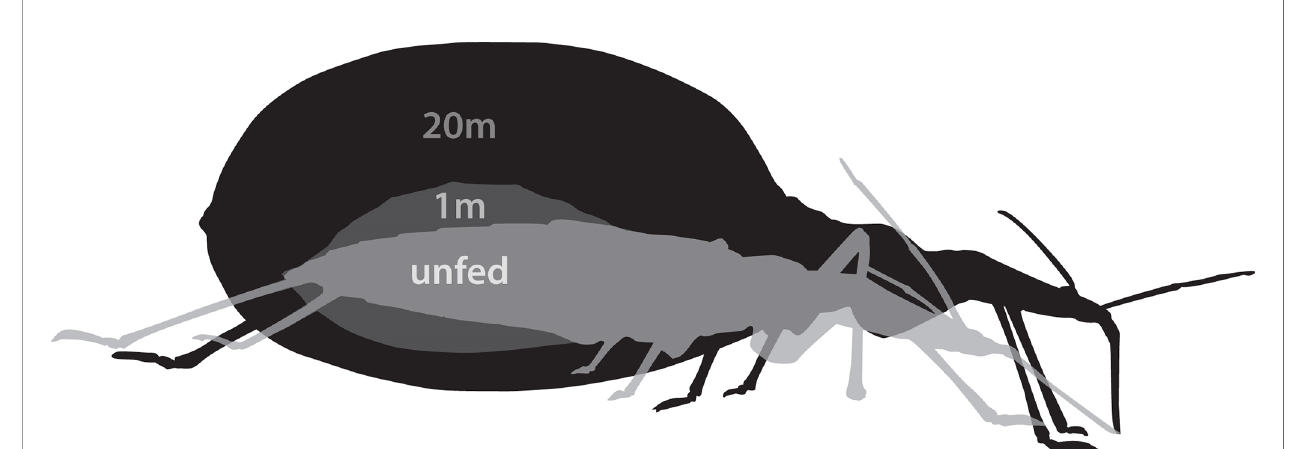
FIGURE 1 | Drawing depicts the change in body shape of fi fth instar Rhodnius prolixus during blood gorging. Note that as the insect transitions from an unfed, through 1 minute (1 m) and 20 minutes (20 m) of blood gorging, body shape expands in all directions, including anterior to posterior, to accommodate a blood meal that can be up to 10 times the insect ’ s initial body